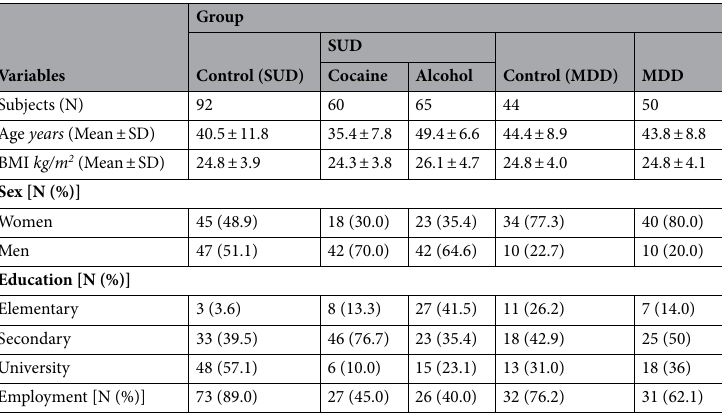
Table 1. Socio-demographic variables of the sample. BMI body mass index, MDD major depressive disorder, SUD substance use